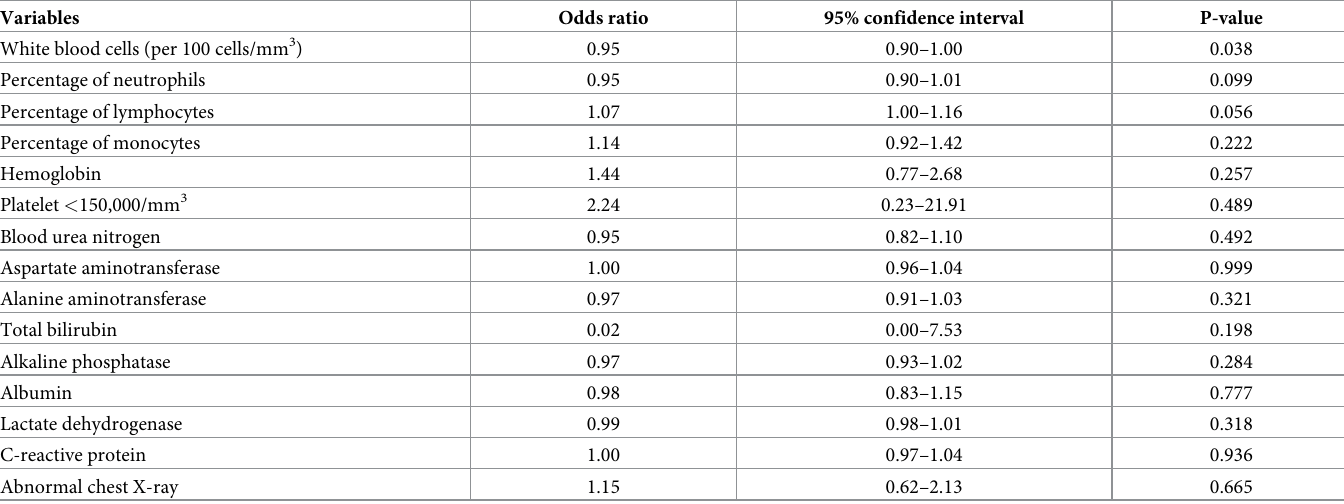
Table 5. Univariate logistic regression analysis of associated factors for COVID-19 (laboratory results).